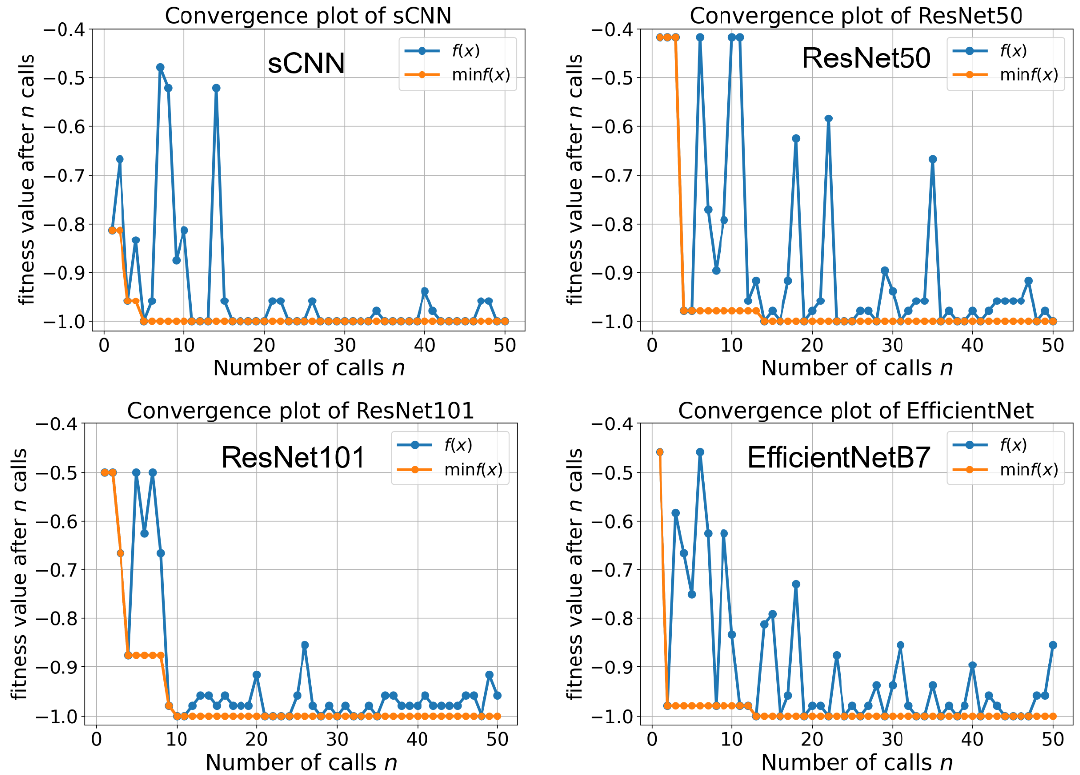
Figure 4. Convergence plot of each model during hyper-parameter optimization.